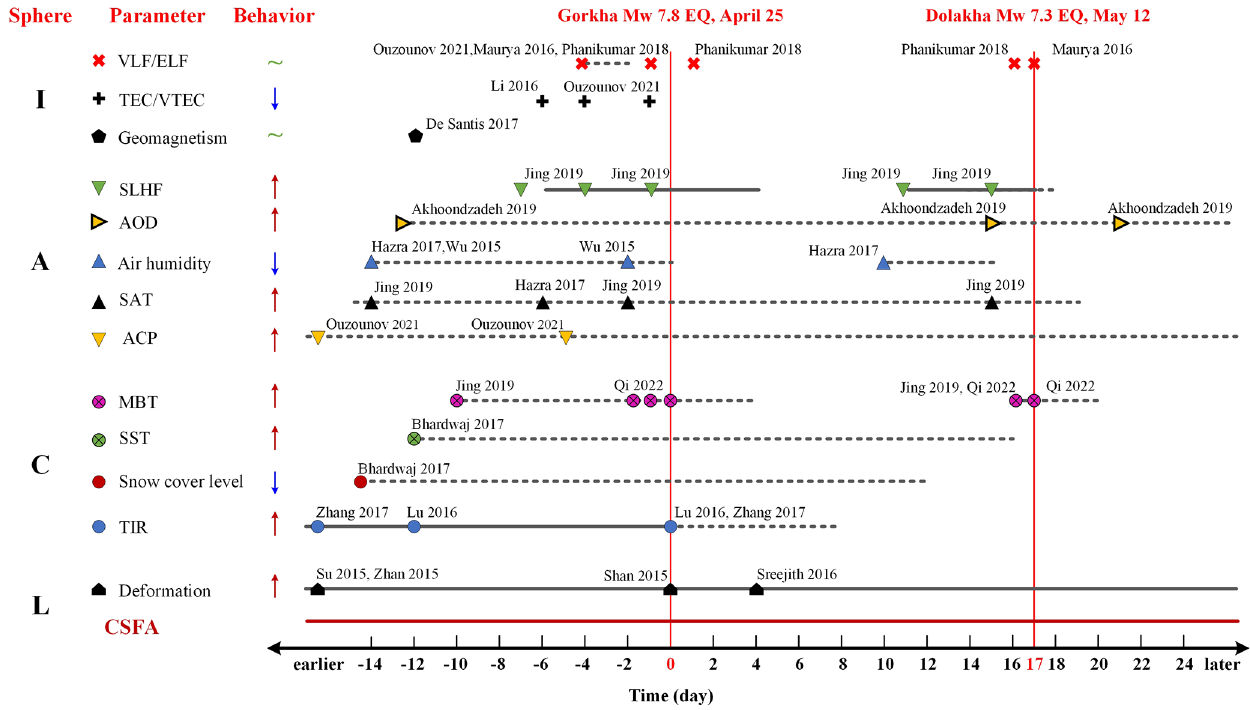
Figure 7. The temporal distribution of screened seismic anomalies, which could be attributed to CSFA and stress-activated P-holes. ↑ denotes positive anomaly, while ↓ means negative anomaly, and ∼ represents fluctuating or discrete